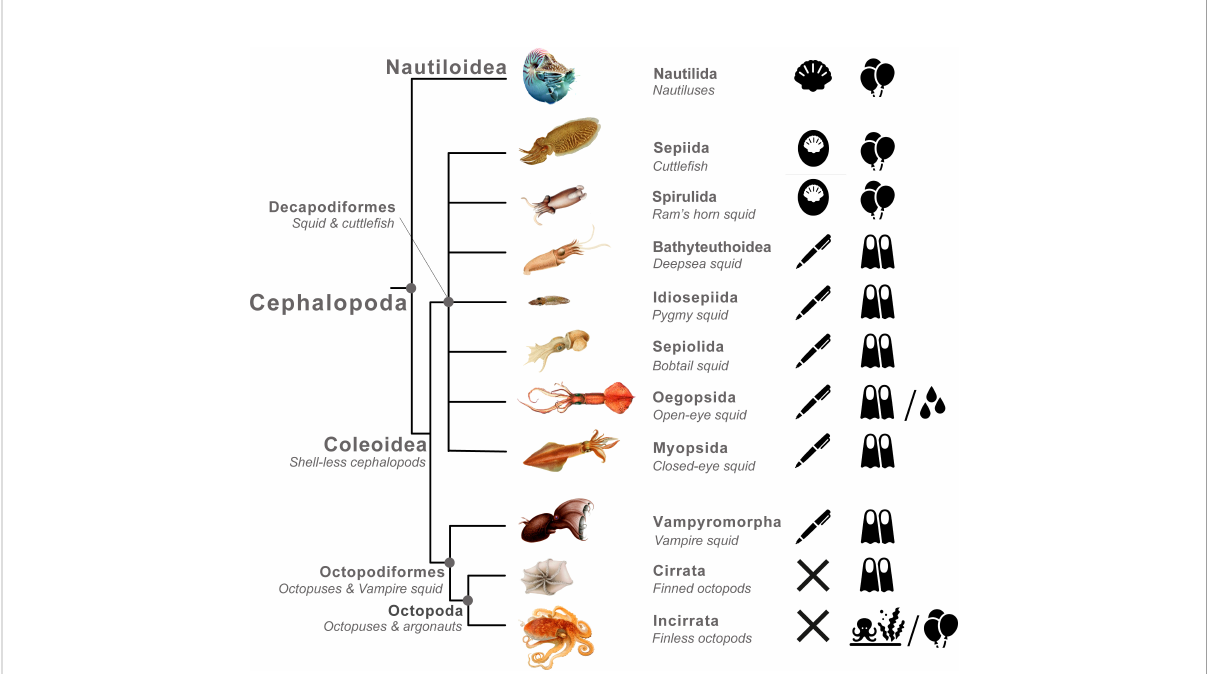
FIGURE 1 Phylogenetic tree illustrated with shell structures and buoyancy mechanisms exhibited by cephalopods. The shell is an important character in the evolution of anti-predator strategies in Cephalopoda. There has been a transition from a protective outer structure to a buoyancy device, or loss in some groups, corresponding with major transitions in lifestyle and the way that different cephalopod lineages interact with predators. Nautiluses, cuttle fi sh and ram ’ s horn squid possess a shell containing gas fi lled chambers used to modify buoyancy, that is either: external in nautiluses, or internal in cuttle fi sh and ram ’ s horn squid; Decapod squid and the vampire squid possess a greatly reduced shell called a pen (or ‘ gladius ’ ) and use either: (i) low density fl uid or (ii) hydrodynamic lift generated by fi nning to modulate buoyancy; Octopuses and bobtail squid have completely lost the ancestral cephalopod shell and have either: (iii) adapted to a benthic lifestyle, (iv) evolved to use a swim bladder (in the ‘ football octopus ’ ), or (v) evolved use of the egg case to generate buoyancy (in ‘ paper nautiluses ’ ). (Illustrations from Jatta, 1896; Chun, 1910 & Meyer, 1913). Icons on the right of the fi gure represent the following: black shell – presence of an external shell; white shell within black oval – presence of a reduced internal shell; pen – presence of a pen or gladius; cross – complete absence of a shell; balloons – neutral buoyancy achieved via gas fi lled chambers or spaces; fi ns – neutral achieved via hydrodynamic lift; water droplets – neutral buoyancy achieved via low density fl uid fi lled chambers; benthic octopus – evolved a benthic lifestyle. Cephalopod illustration credits are as follows: Nautilus, Lee R Berger, CC BY-SA 3.0, https://en.wikipedia.org/ wiki/File:Nautilus_pro fi le.jpg; Ocythoe tuberculata, Eledone aldrovandi, Argonauta argo, Jatta, 1896; Rossia mastigophora, Mastigoteuthis glaukopis, Vampyroteuthis infernalis, Cirruthauma murrayi, Spirula spirula, Chun, 1910; Sepia of fi cianalis, Loligo vulgaris, Meyer,